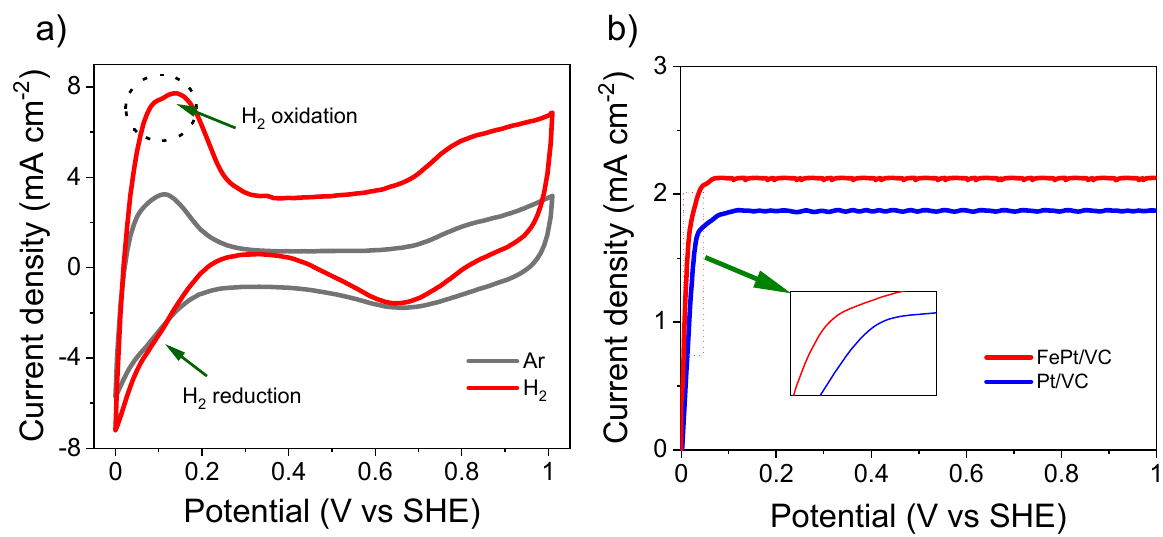
Figure 3. HOR activity of FePt/VC, including ( a ) its CV at scan rate 50 mV s − 1 @ 1600 rpm in 0.1 M aqueous HClO 4 under saturated Ar and H 2 , and ( b ) LSV comparison between FePt/VC and Pt/VC at the scan rate of 10 mV s − 1 @ 1600 rpm under saturated H 2 . Catalyst loading was 50 µg cm − 2 .